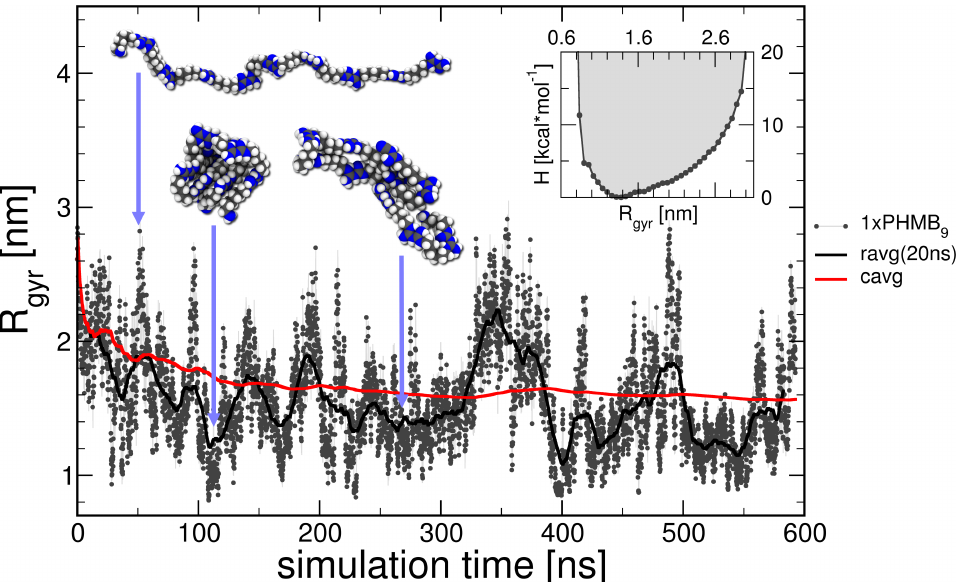
Figure 1. Self-aggregation dynamics of a single PHMB nonamer in aqueous solution by means of R gyr . Snapshots in atomistic representation illustrate high and low R gyr states (N: blue; C: grey; H: white). Point representation of the raw data is plotted only every 100 ps. A running average (ravg) with a windows length of 20 ns is applied to smooth the raw data. A cumulative average (cavg) is utilized to appreciate convergence of the ensemble. While the polymer continuously traverses between compact and extended folds, the cavg measure should approach a constant value with increased simulation time. The insert (upper right) shows the free enthalpy obtained by the Boltzman inversion of the R gyr probabilities (50 bins). As seen, only a broad minimum with no significant energy barriers exists to distinguish the different folding states, thus indicating no distinct fold in